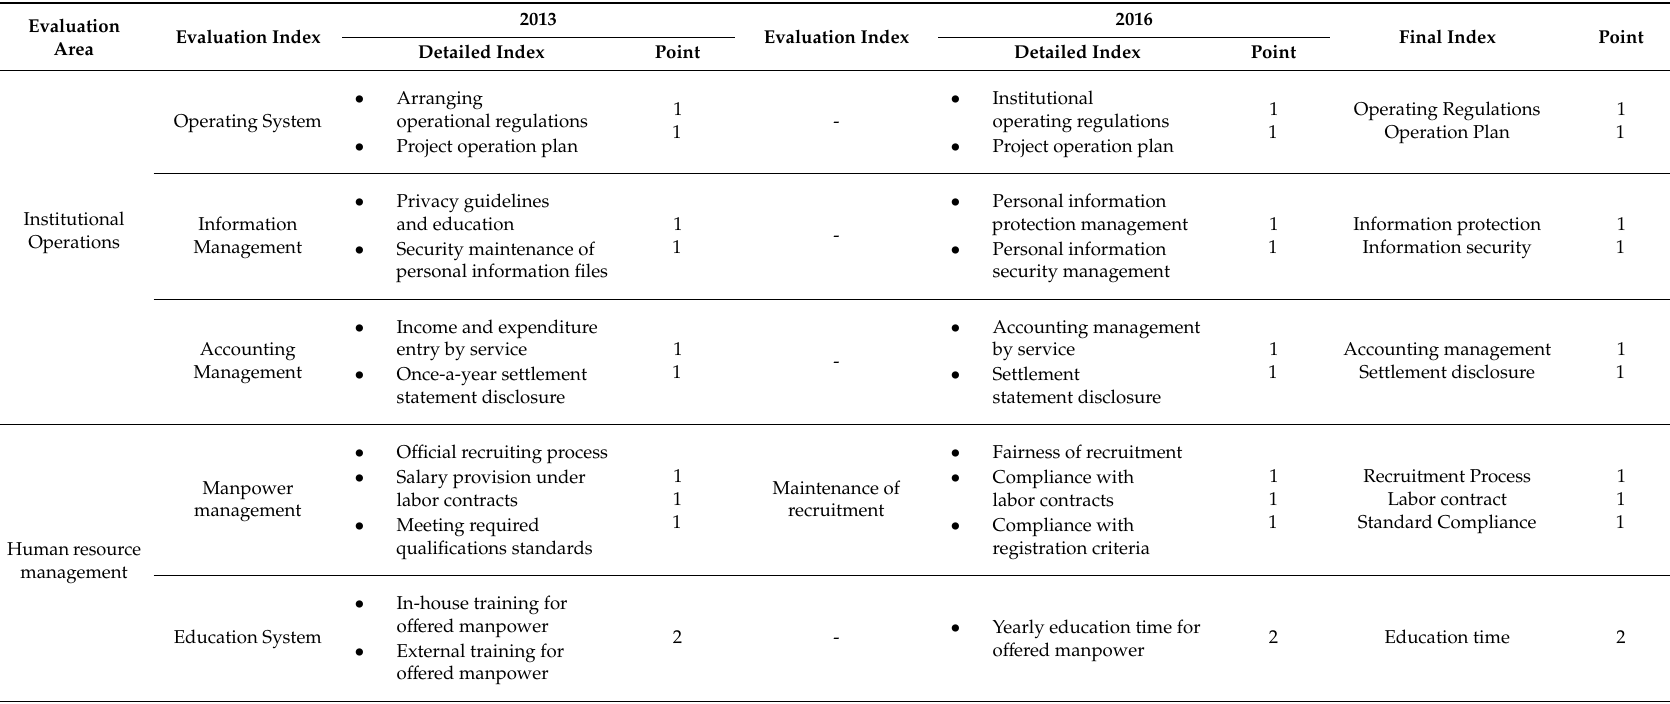
Table A1. Common indexes for the quality evaluation (QE) of social services in 2013 and